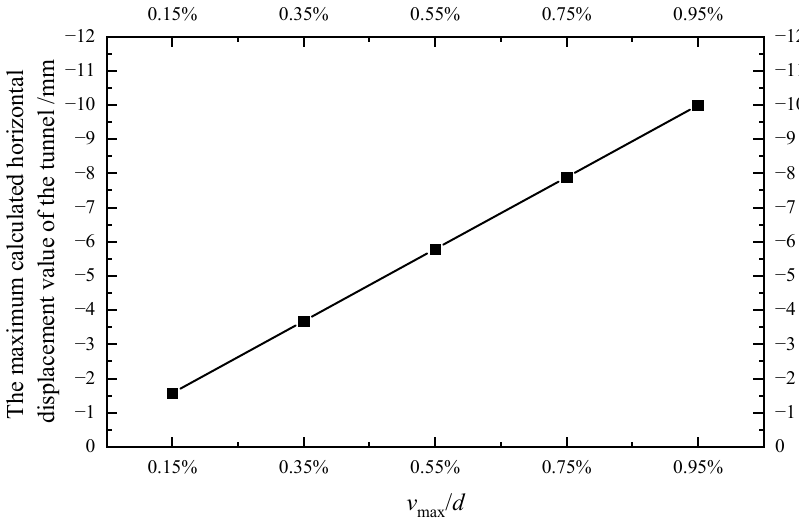
Figure 16. The variation curve of the maximum calculated value of the shield tunnel’s horizontal displacement with different values of v max / d .